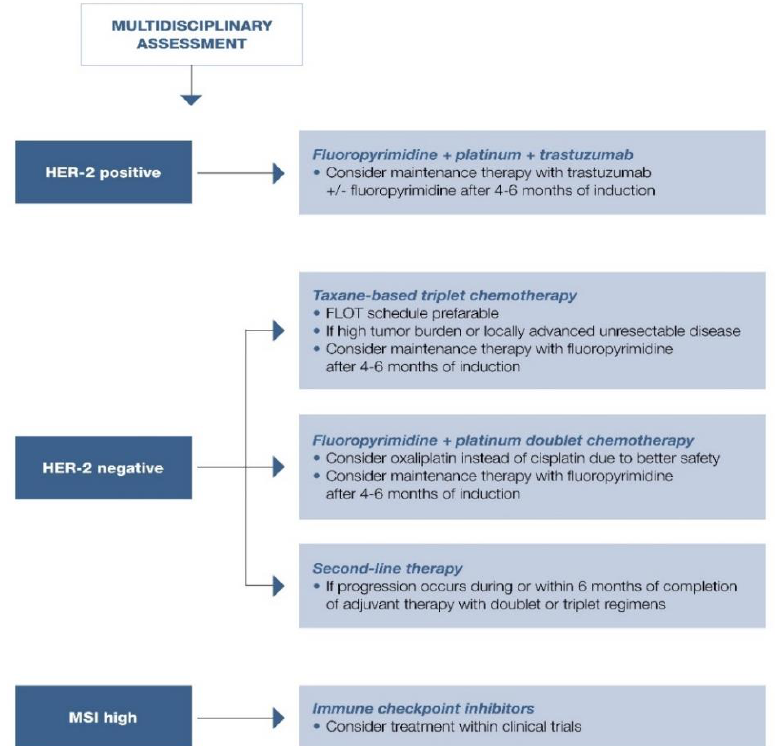
Figure 4. First-line treatment options for fit patients with metastatic or unresectable gastric or gas- troesophageal junction adenocarcinoma. FLOT, 5-fluorouracil/leucovorin, oxaliplatin, and docetaxel; MSI, microsatellite instability.